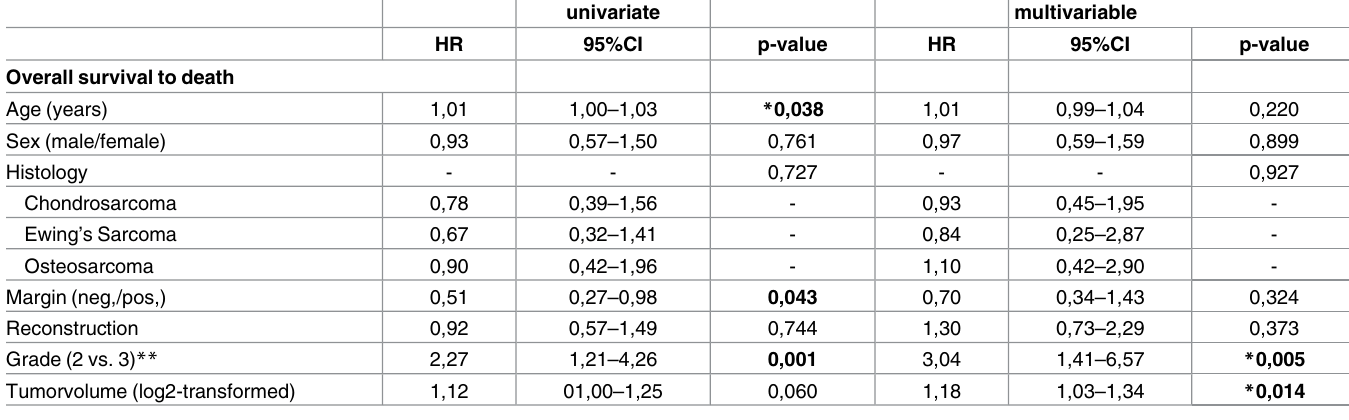
Table 2. Univariate and multivariable Cox regression models for overall survival to